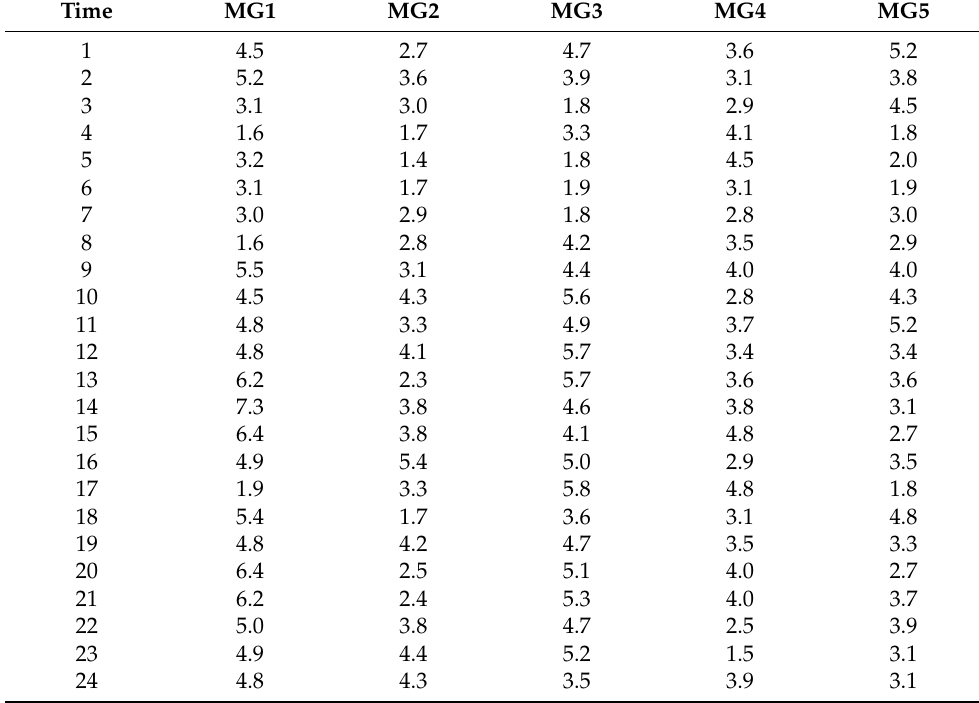
Table 8. Total power generated in MW for each MG using the ANN-BBSA schedule controller for 24